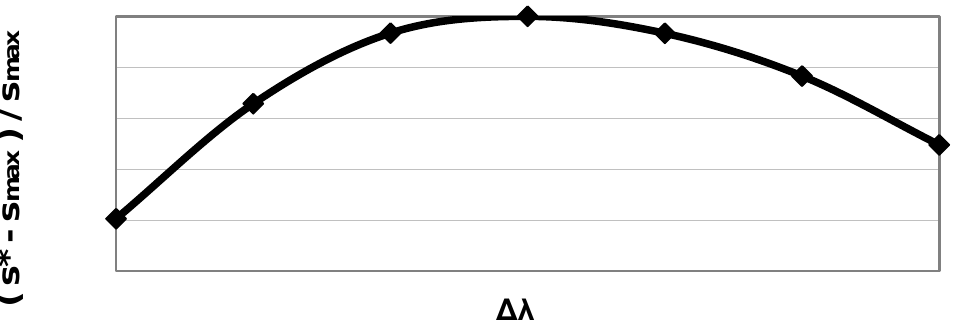
Figure 5. Sensitivity analysis on deviations to optimal average speed from variations modal split parameter λ